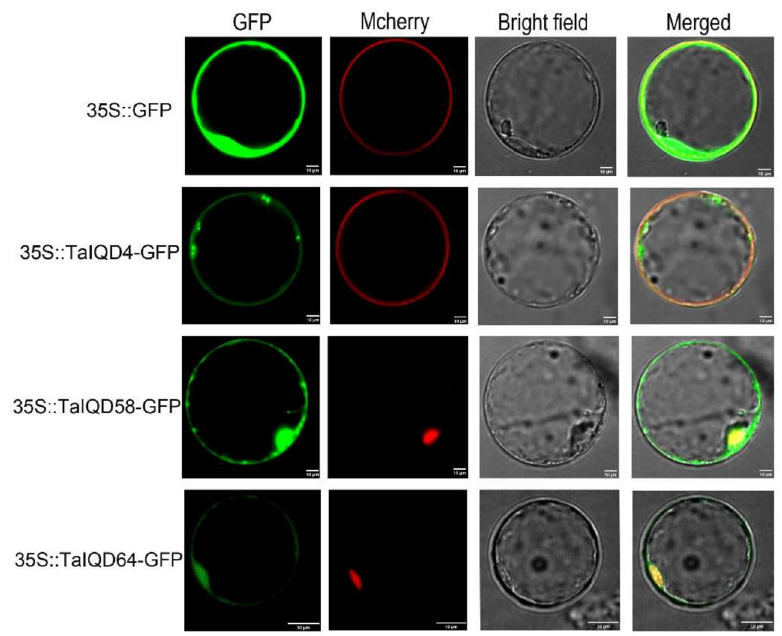
Figure 10. Subcellular localizations of TaIQD4, TaIQD58, and TaIQD64 in rice protoplasts. Scale bars = 10 µ m. 35S::GFP was used as the empty